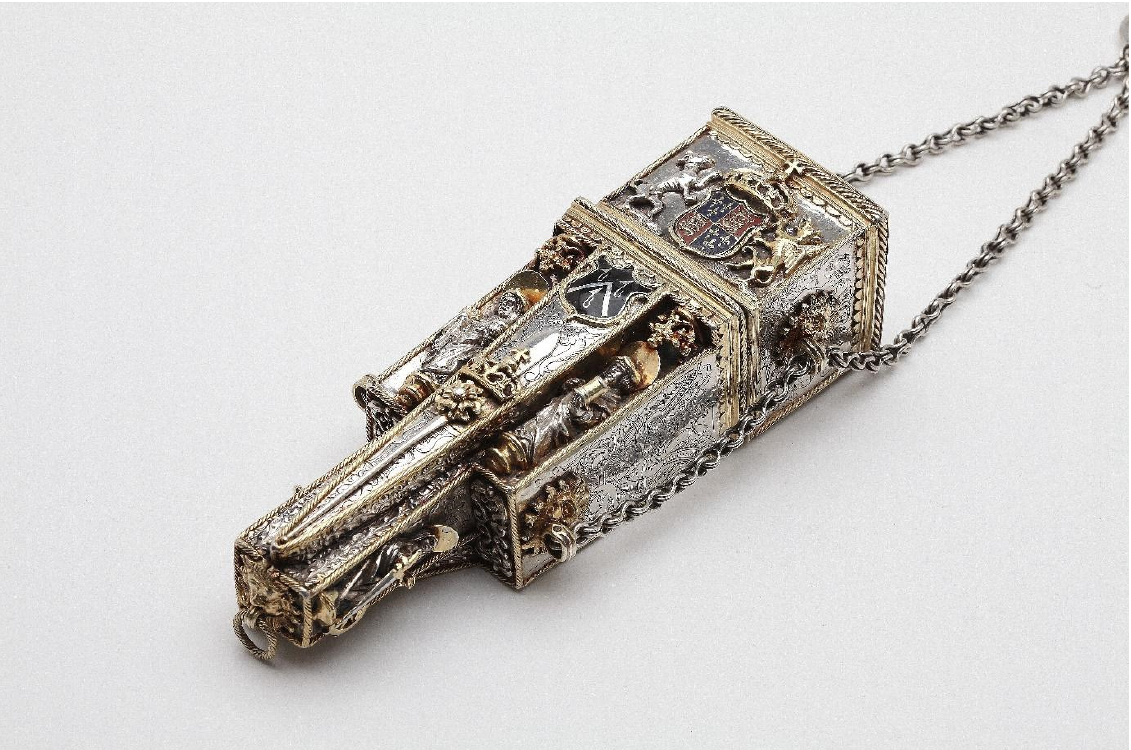
Figure 1. Instrument case, front. From the collections of the Worshipful Company of Barbers,